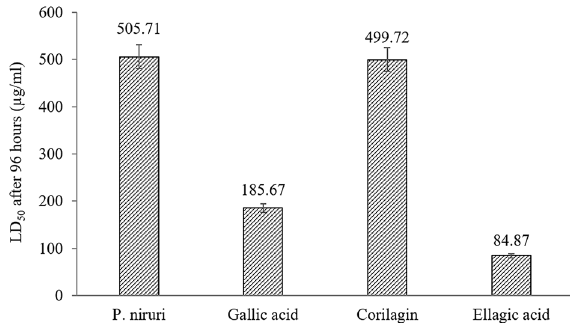
Figure 7. LD 50 values for P. niruri extract and standard